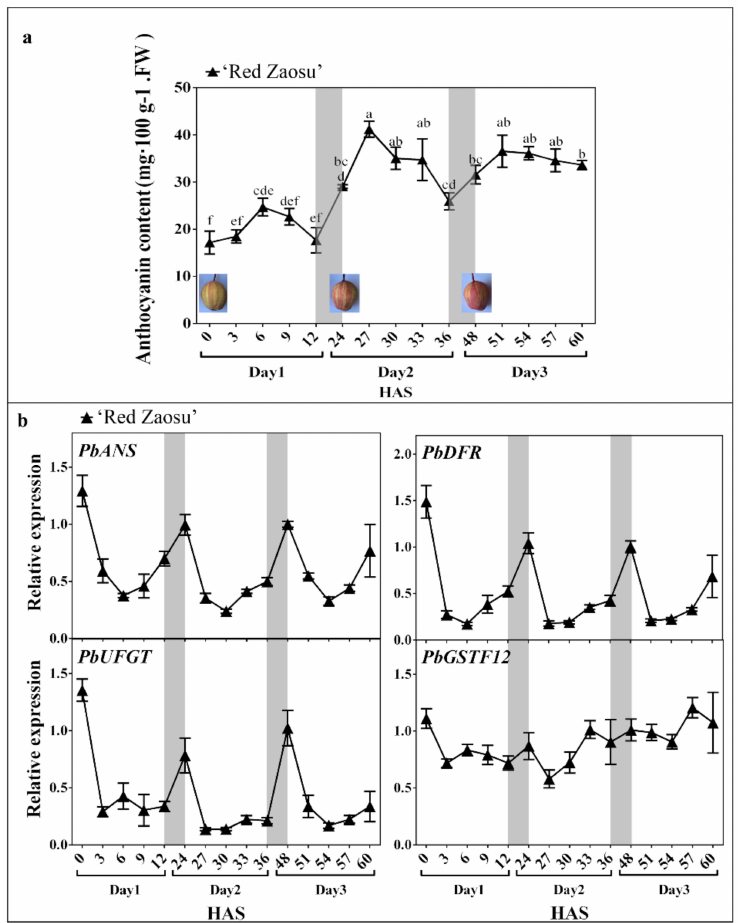
Figure 1. Daily change patterns in anthocyanin content, and the expression patterns of anthocyanin late biosynthetic genes ( ALBG s) and a typical anthocyanin transport gene, PbGSTF12 , in ‘Red Zaosu’ pear fruit skin. ( a ) The anthocyanin content in the fruit skin of ‘Red Zaosu’ over three continuous days. Images show the ‘Red Zaosu’ phenotypes at three time points over the three continuous days. ( b ) The expression patterns of ALBG s and PbGSTF12 in ‘Red Zaosu’ fruit skin over three continuous days. The gray boxes indicate nighttime. The NCBI accession numbers of the ALBG s and PbGSTF12 are listed in Supplementary Table S1. HAS: hours after sunrise of day 1. Error bars represent the standard errors (SEs) of the means ( n = 3). Data in (a) was determined using a one-way analysis of variance ( p < 0.05); the significant di ff erences are indicated by di ff erent lowercase